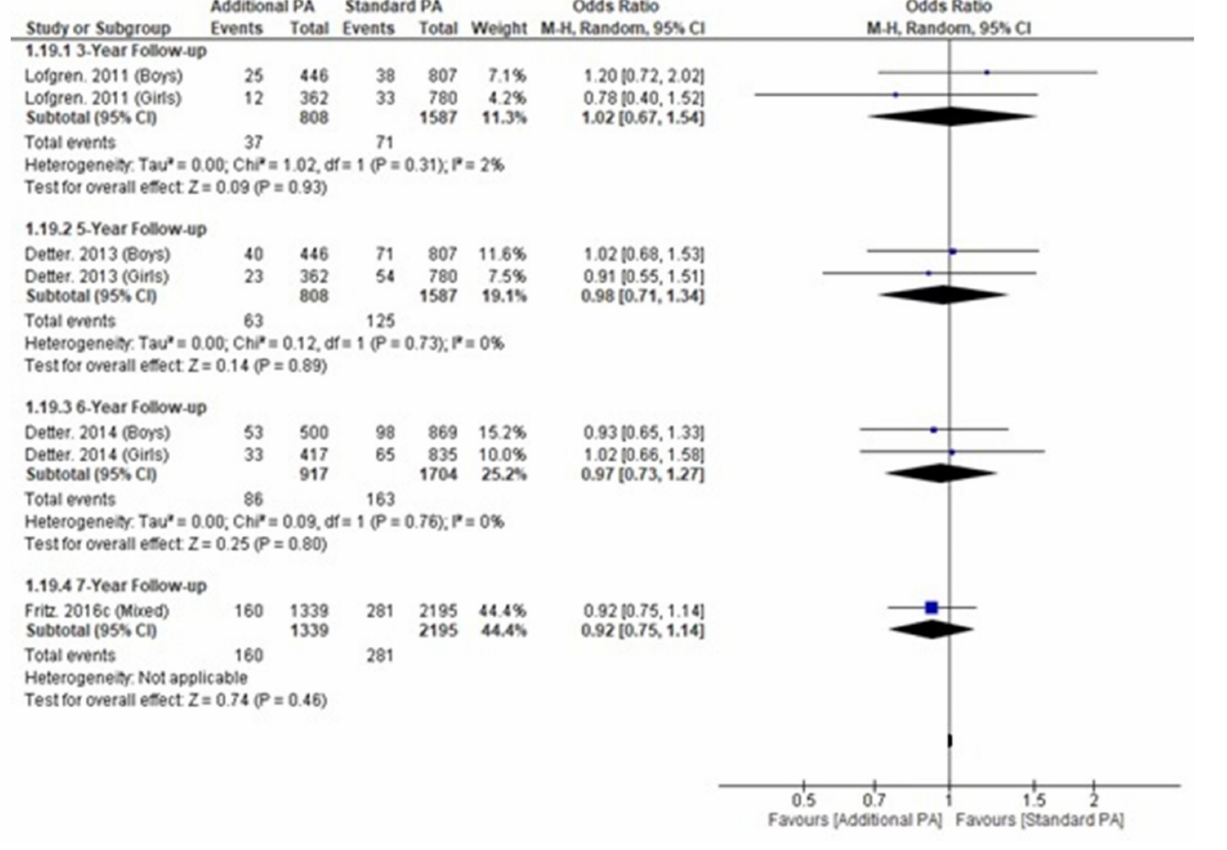
Figure 5. Fracture incidence within a single longitudinal trial over